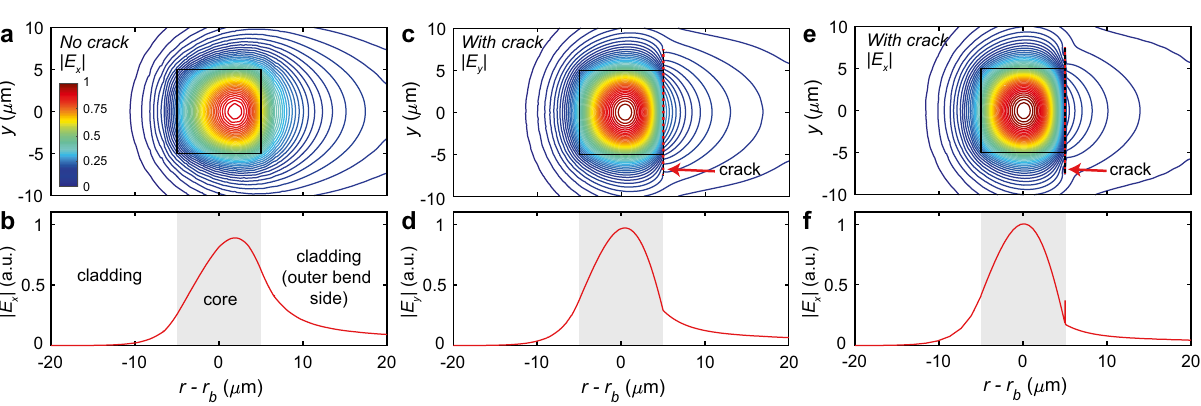
Figure 3. Simulated effect of crack on modal confinement in curved waveguides. ( a , b ) Fundamental mode electric field profile and cutline across z = 0 for the case r b = 7 mm without crack for x polarization, ( c , d ) with crack for y polarization and ( e , f ) with crack for x polarization. Waveguide is 10 × 10 μm; crack is 30 nm wide and 15 μm high located on outer bend edge of waveguide indicated by dotted red line; (cid:31) = 1.55 μm. Shaded grey region in cutline plots indicates extent of